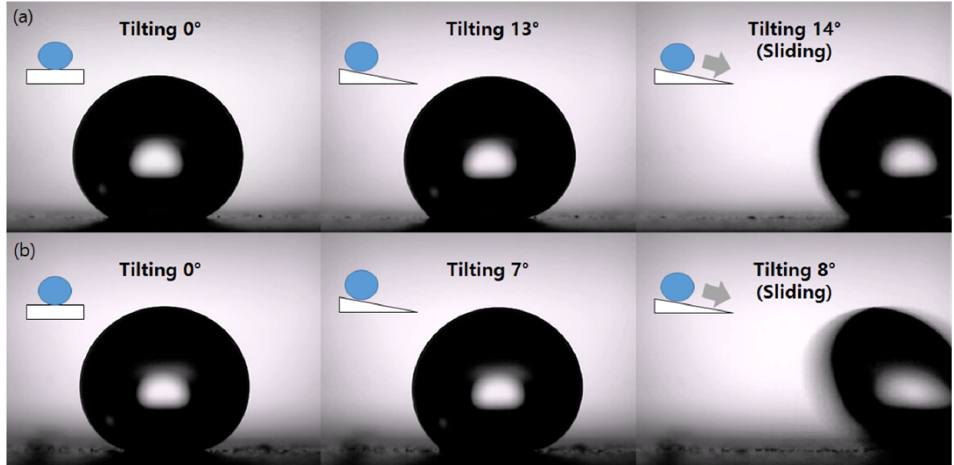
droplet could move along the microscale groove patterns more easily because of the lower SA || . This phenomenon is comparable to rice leaves [1,13].